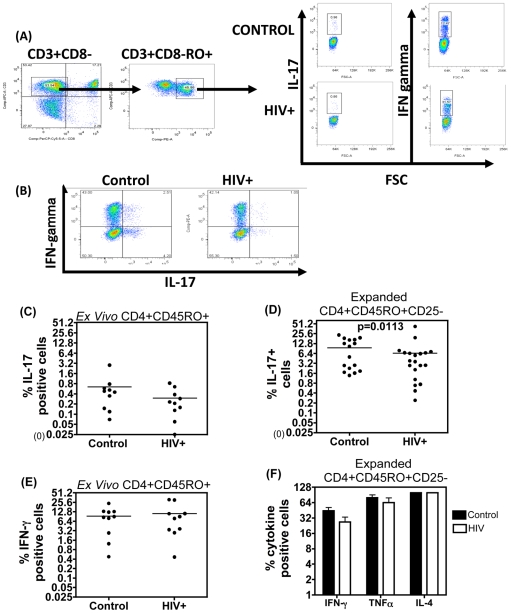
Impaired IL-17 production by IL-2 expanded effector cells from HIV+ subjects.IL-17A, IFN-γ, IL-4 and TNFα production was measured from expanded CD4+CD25− effector cell lines. Cells were expanded over six days with irradiated APC, IL-2 and purified anti-CD3 Ab and then re-stimulated for 16 hours with PMA/ION in the presence of 5µg/ml brefeldin. (A) Representative FACS plot showing gating strategy in PBMC of ex vivo IL-17 and IFN-γ production after 4 hours of PMA/ION stimulation from a HIV+ patient and healthy control in the presence of brefeldin A. (B) Representative FACS plots show IL-17 and IFN-γ+ CD4+CD25− cell frequency from expanded cells after 16 hr stimulation with PMA/Ionomycin in the presence of 5µg/ml brefeldin A. (C) Frequency of IL-17 and IFN-γ production from ex vivo CD4+CD45RO+ gated cells within PBMC (D). Frequency of total IL-17 positive cells in expanded CD4+CD45RO+CD25− effector cells from controls (N = 16) and HIV+ (N = 20) subjects. Group differences were determined by Fischer's Exact test and 2-sided p-value reported. (E) Frequency of IFN-γ, TNFα and IL-4 positive cells in expanded cell lines from 4 control (black bars) versus 6 HIV+ (white bar) subjects. (F) Differences in these individual cytokines between control v HIV+ samples was assessed by paired t-test and were non significant.